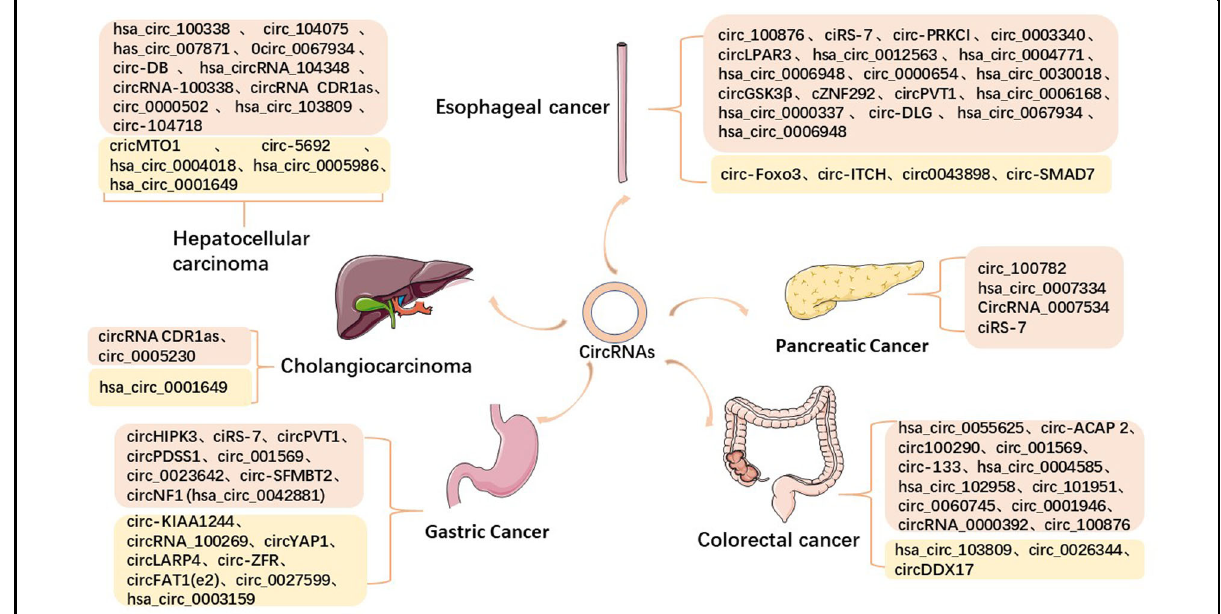
Fig. 1 The expression of circRNA in digestive tract tumors. Some common disorders of circRNAs in digestive system neoplasms; the orange mark is the upregulated circRNAs, the golden mark is the downregulated